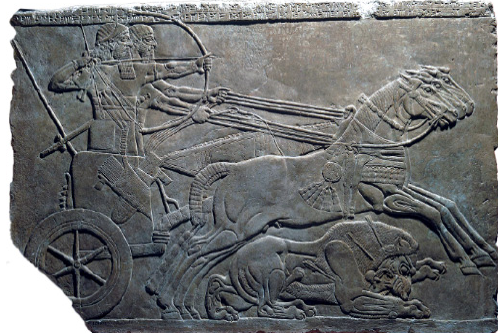
Figure 13. Ashurnasirpal II (or Shalmaneser III) hunting lions (BM inv. no. 124579; reg. no. 1849,1222.8); gypsum relief; Northwest Palace, Nimrud (mod. Iraq); Neo-Assyrian, ca. 865–860 BCE [image courtesy of the Trustees of the British Museum, London].